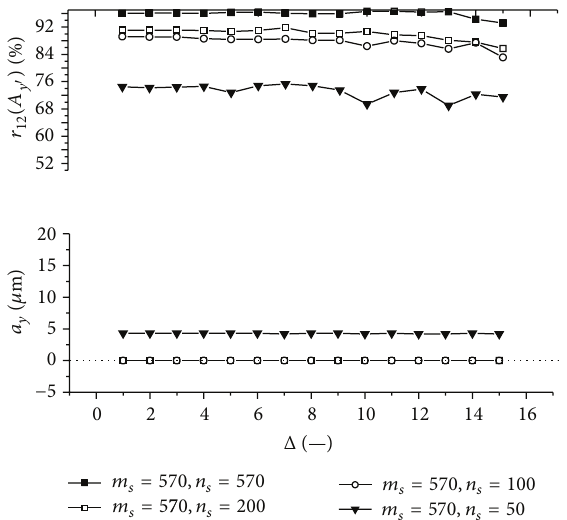
Figure 18: The evaluated object’s translation component 𝑎 𝑦 as well as the maximum 𝑟 12 (𝐴 𝑦 󸀠 ) of the 1D normalized cross-correlation function of intensity signals 𝐼 1 and 𝐼 2 acquired from decimated 2D intensity signals of various size as a function of the factor Δ . Mean speckle sizes are 𝛼 𝑥 󸀠 = 133.6 𝜇 m and 𝛼 𝑦 󸀠 = 117.7 𝜇 m. The object is translated by 𝑎 𝑥 = 100 𝜇 m and 𝑎 𝑦 = 0𝜇